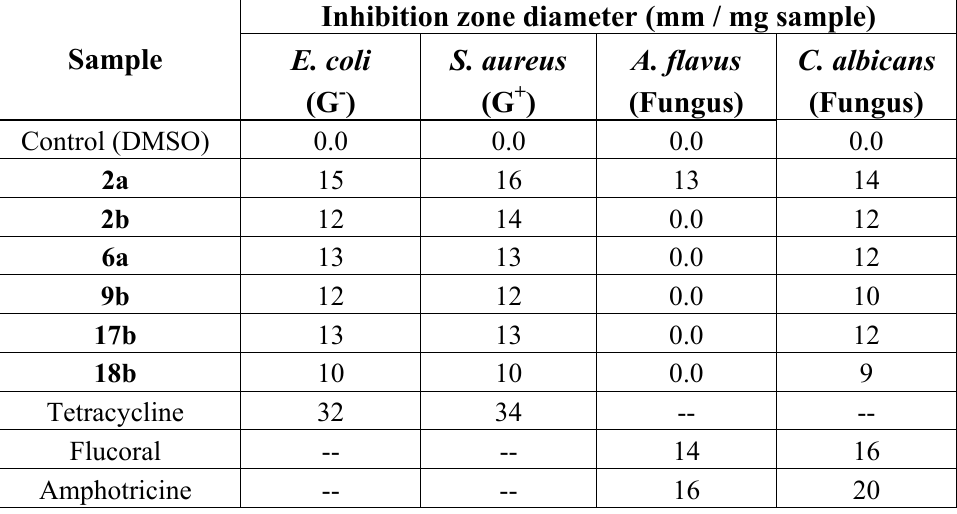
Table 1. Antimicrobial activities of the tested